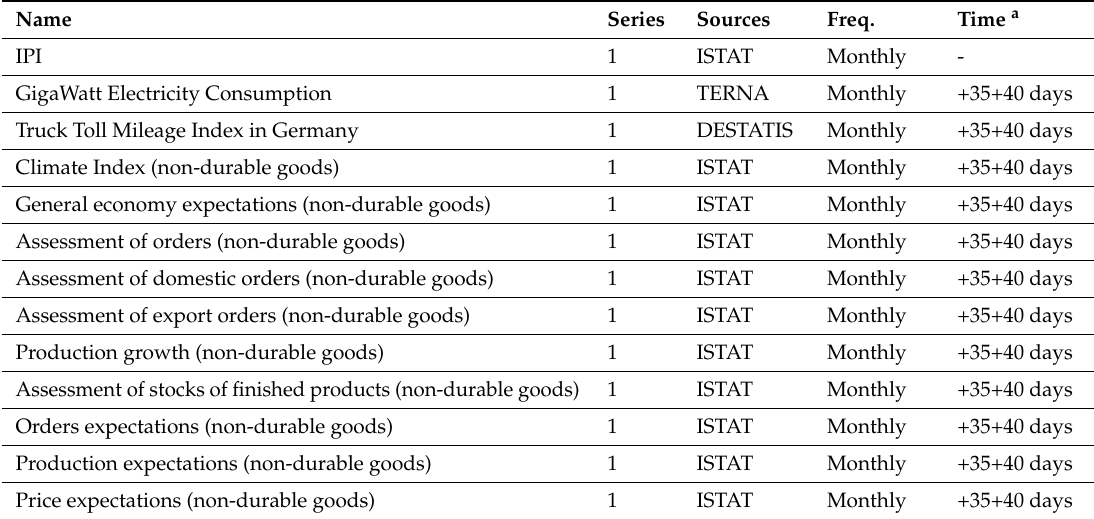
Table 2. Information sources of data for VARMA using survey